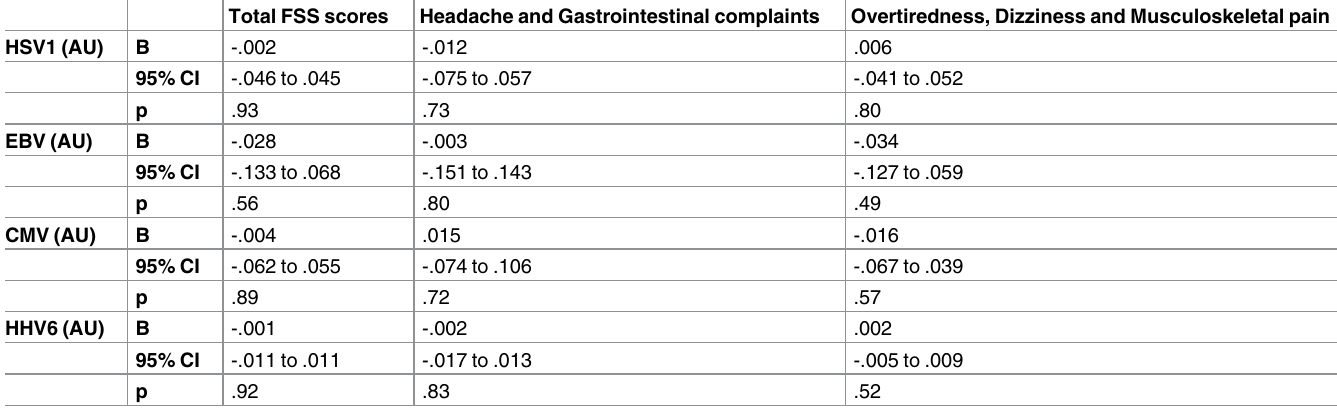
Table 2. Associations between the levels of viral antibodies and FSS.